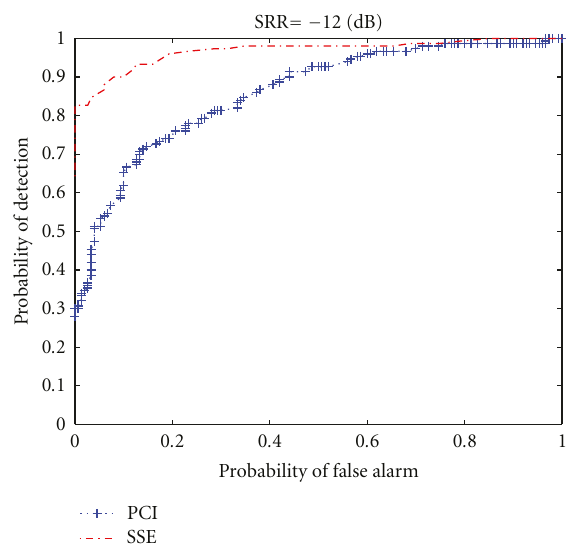
Figure 6: Experimental ROC curves for PCI and SSE with an SRR of − 12